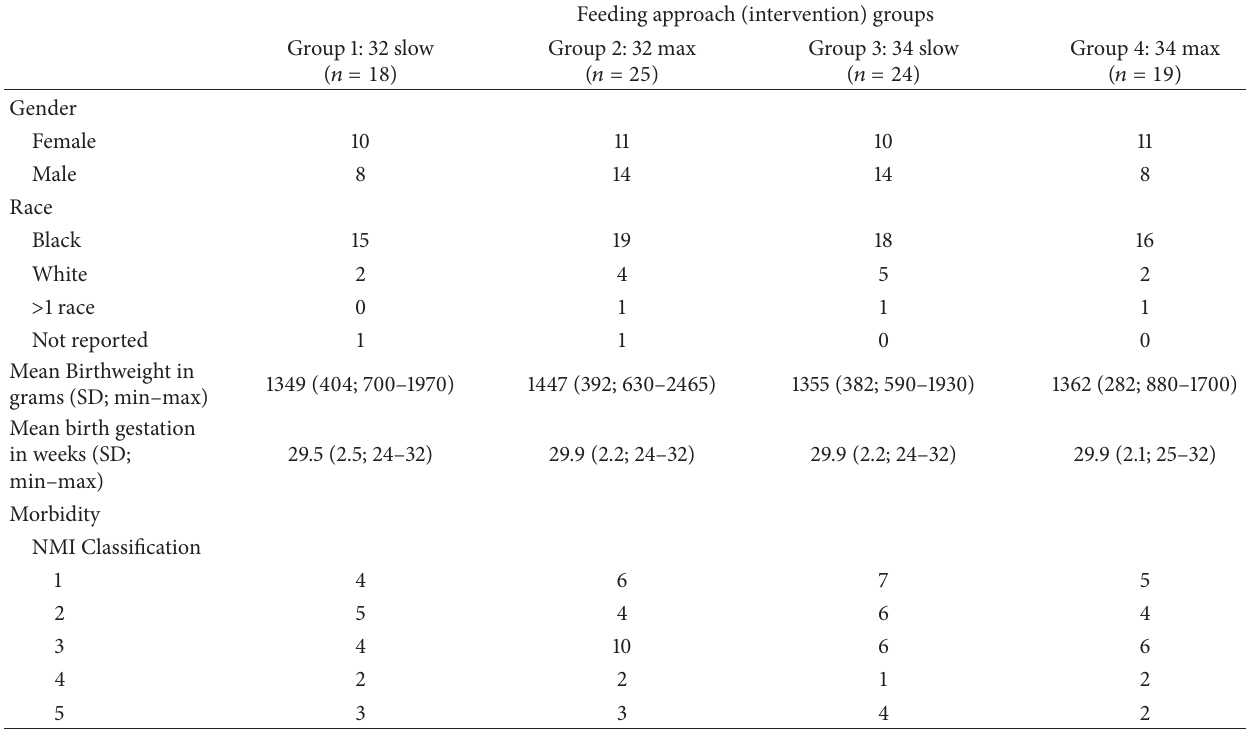
Table 2: Participant characteristics. Feeding approach (intervention)